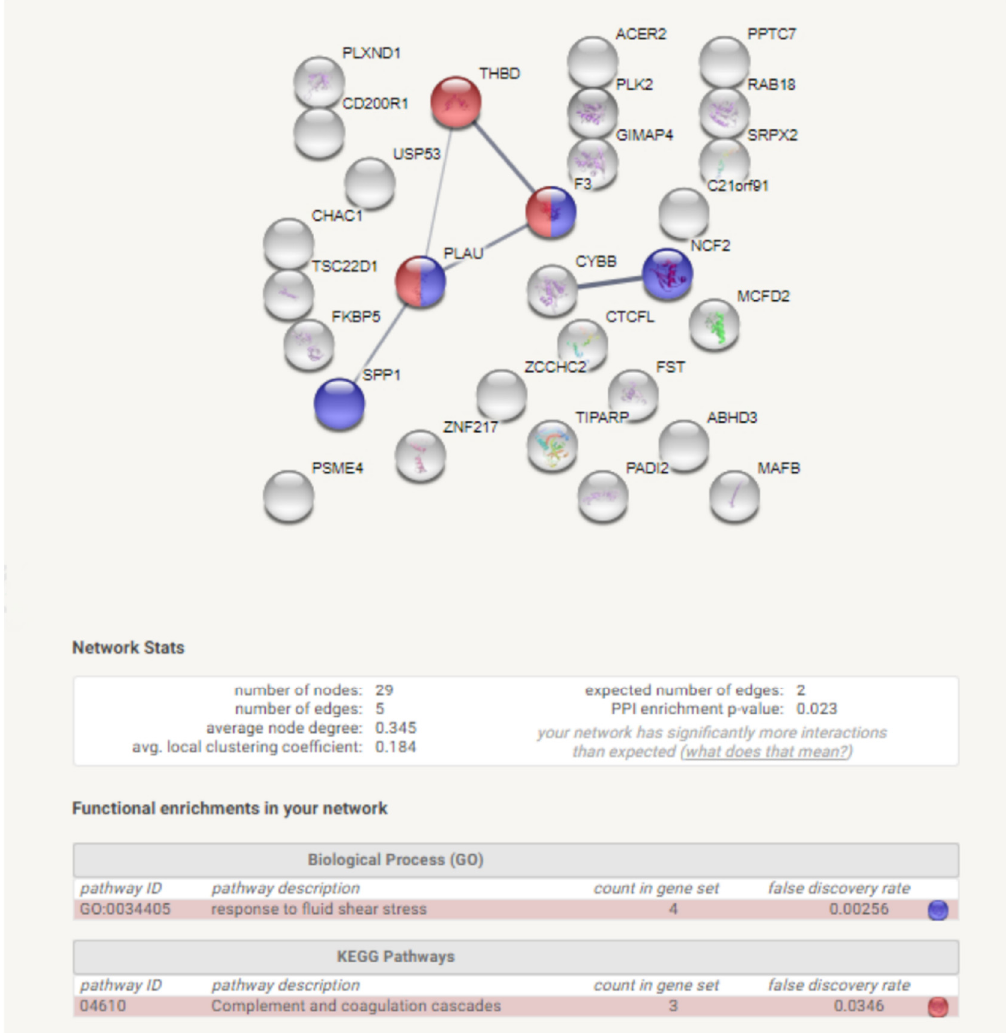
Figure 4. Gene network created from DEGs identified in rapeseed oil vs. beef tallow comparison.